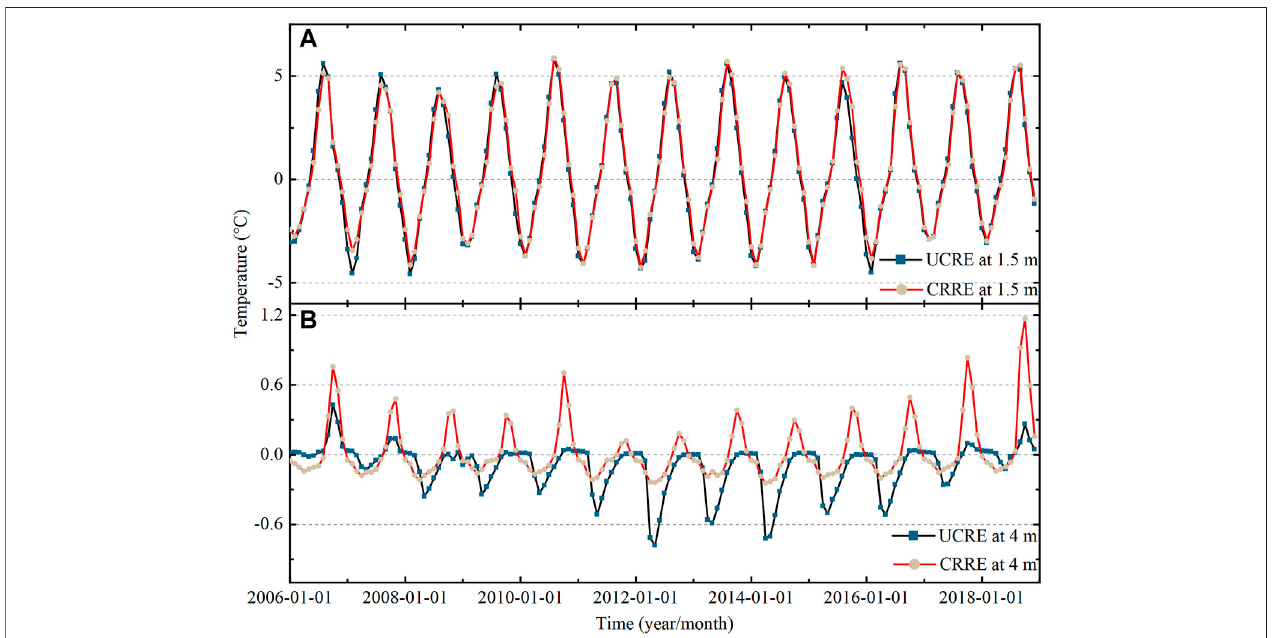
FIGURE 8 | Permafrost temperature variations at depths of 4.5 m (A) , 10 m (B) and 20 m (C) beneath the left shoulder of the embankments.